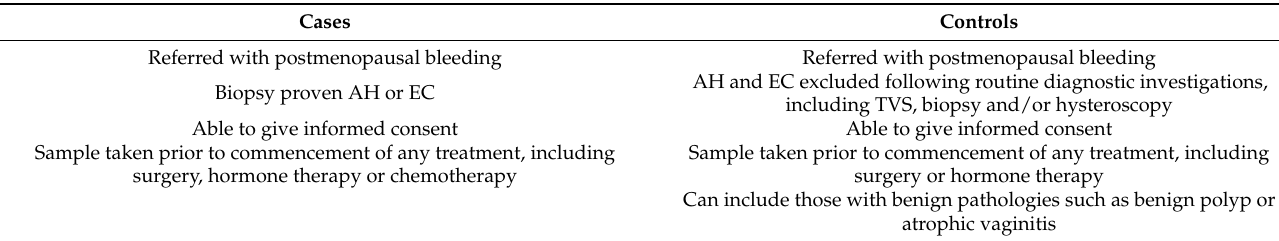
Figure 2. Sample pool strategy used for library generation. This is based on both cervico-vaginal supernatant and pellet samples. Three AH samples were pooled together while two pools were made from five cancer samples (cancer pool 1) and 4 cancer samples (cancer pool 2) respectively. The seven control samples were also pooled in two, based on four samples (control pool 1) and three samples (control pool 2) respectively. List of pooled samples used in library generation are summarised in Table 2. Table 1. Eligibility criteria for case and control selection.